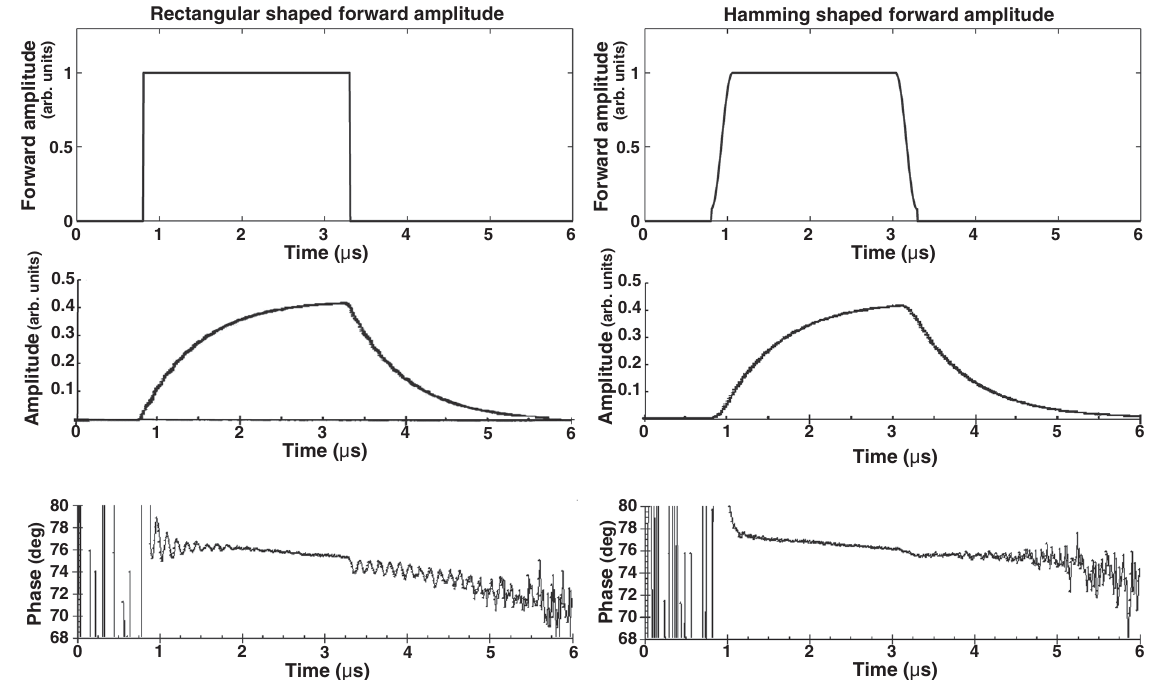
FIG. 26. Gun rf amplitude and phase with “ rectangular ” (left plots) and with “ Hamming ” (right plots) rf pulse shape excitation. The rectangular shaped forward pulse also excites the nearest undesired mode 8.1 MHz away from the π -mode.